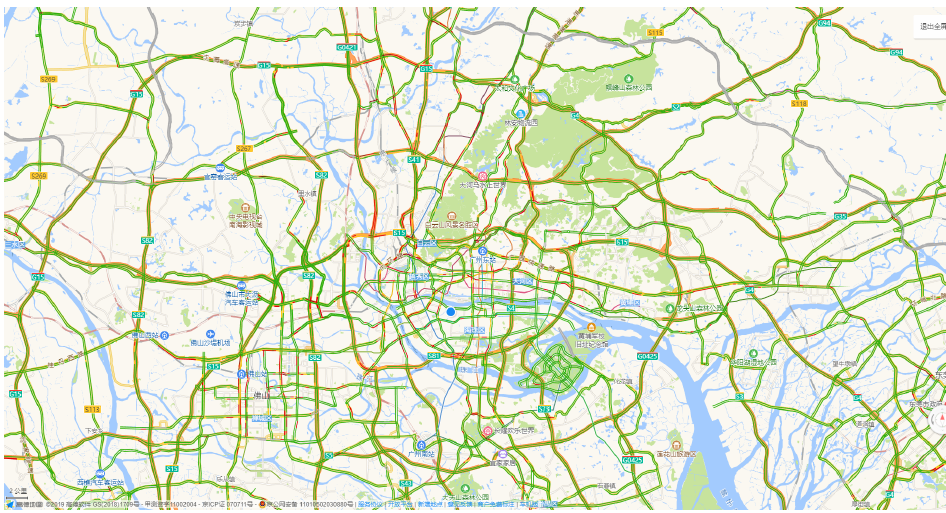
Figure 2. Traffic information from Gaode Map (© 2019). Table 1. Physical parameterization configurations for WRF v3.7.1